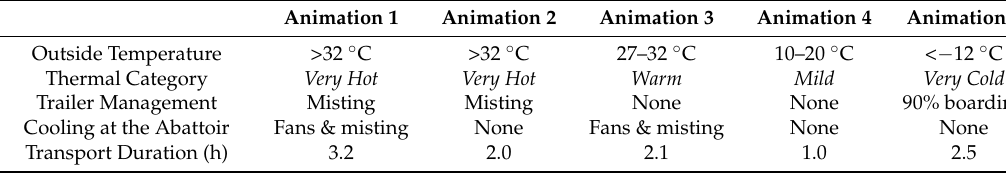
Table A1. Descriptive information of the five animations with reference to pages 6,